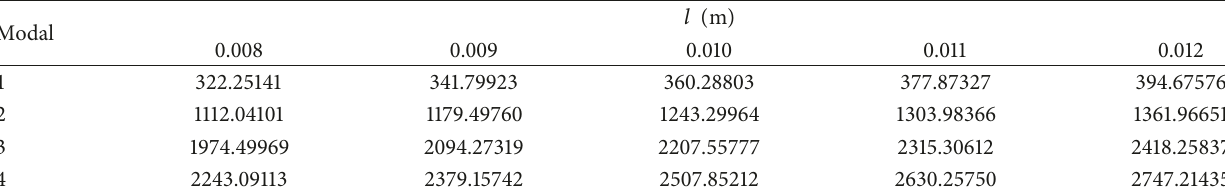
Table 3: Frequencies of different lengths of the unit cell.